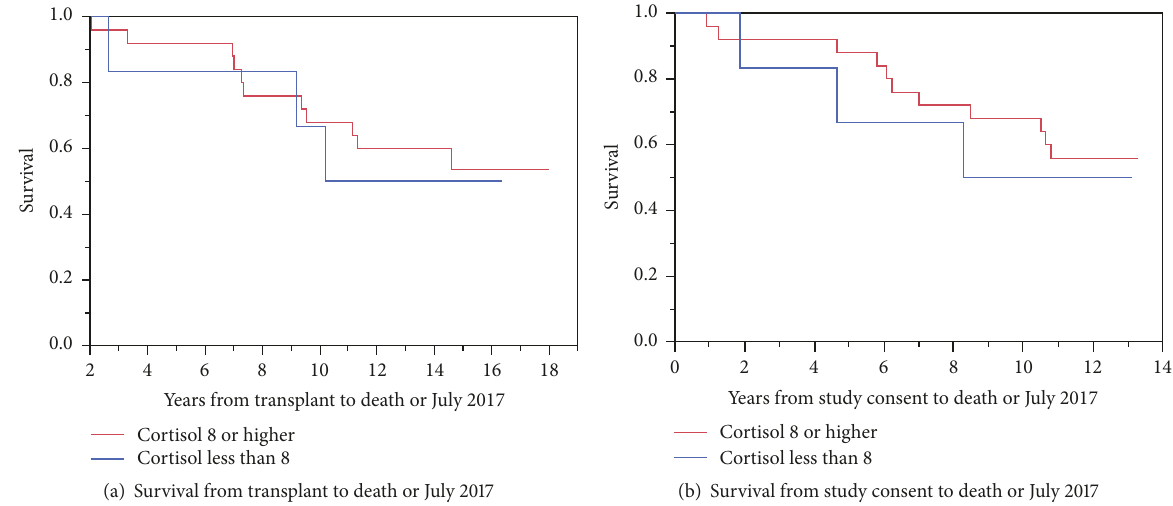
Figure 3: Survival after study